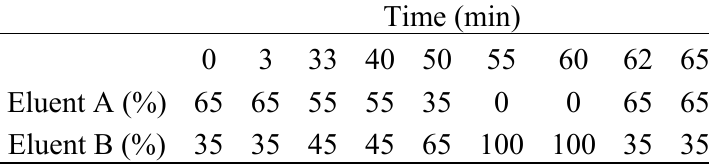
Table 2. Eluent gradient conditions used in LC-DAD. In all cases, eluent rate was set at 1 mL·min -1